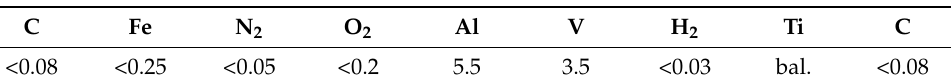
Table 2. Ti6Al4V alloy chemical